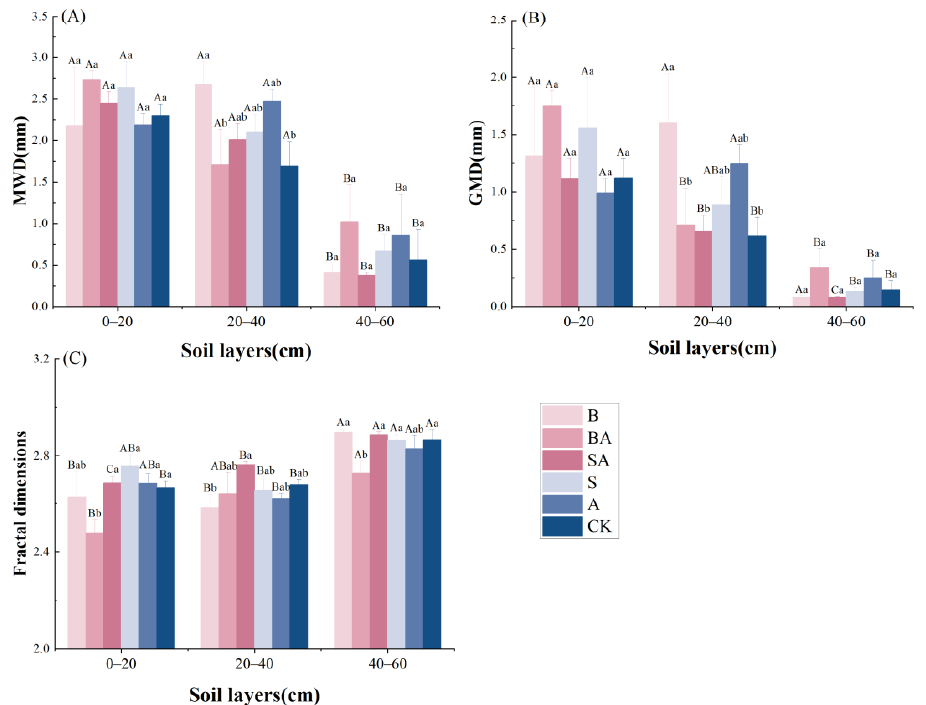
Figure 3. Variations in stability indicators of aggregates between treatments. ( A ) Mean weight diameter of aggregates; ( B ) geometric mean diameter of aggregates; ( C ) fractal dimension of aggregates. Different uppercase letters indicate significant differences between different soil layers with the same treatment ( p < 0.05). Different lowercase letters indicate significant differences between treatments in the same soil layer ( p < 0.05). Error bars refer to standard errors.